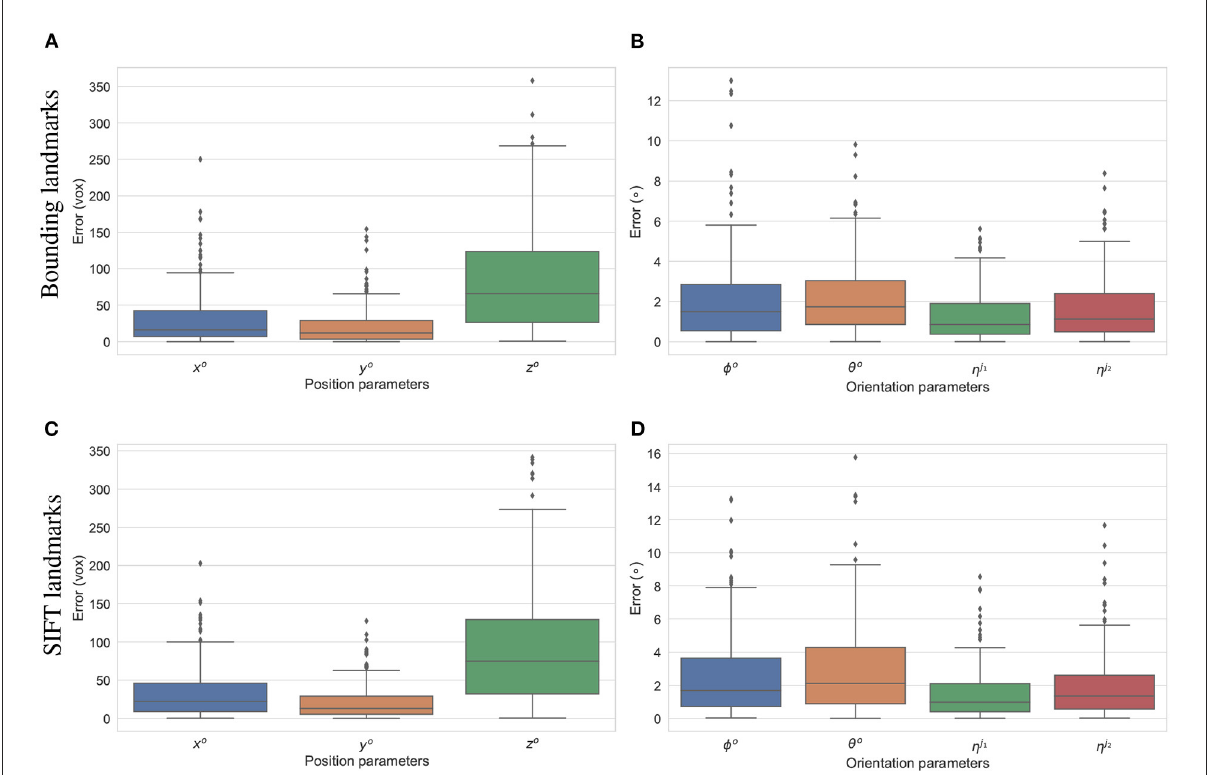
FIGURE12 Estimation errors of the pose parameters using the bounding (A,B) and SIFT (C,D) landmarks. The estimations using the bounding return lower error ranges in comparison to the results using SIFT landmarks, especially for the rotation parameters (B,D) .